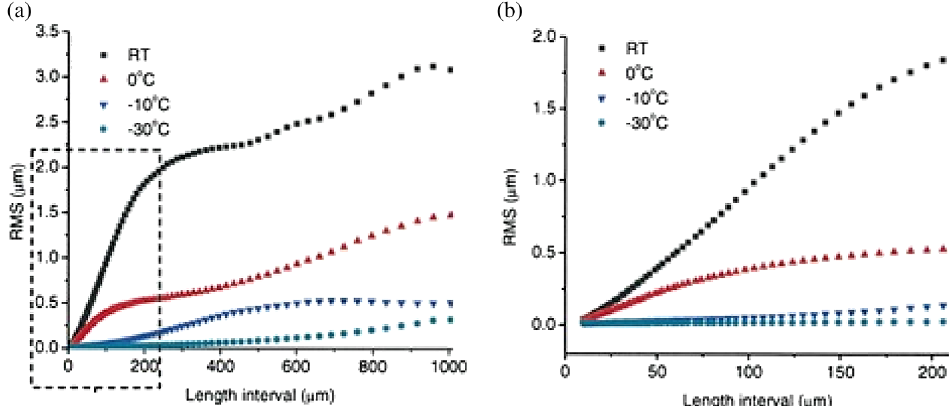
FIG. 4. Stylus profilometry measurements of R q of niobium sheet electropolished in 2N sulfuric acid in methanol at the indicated temperature